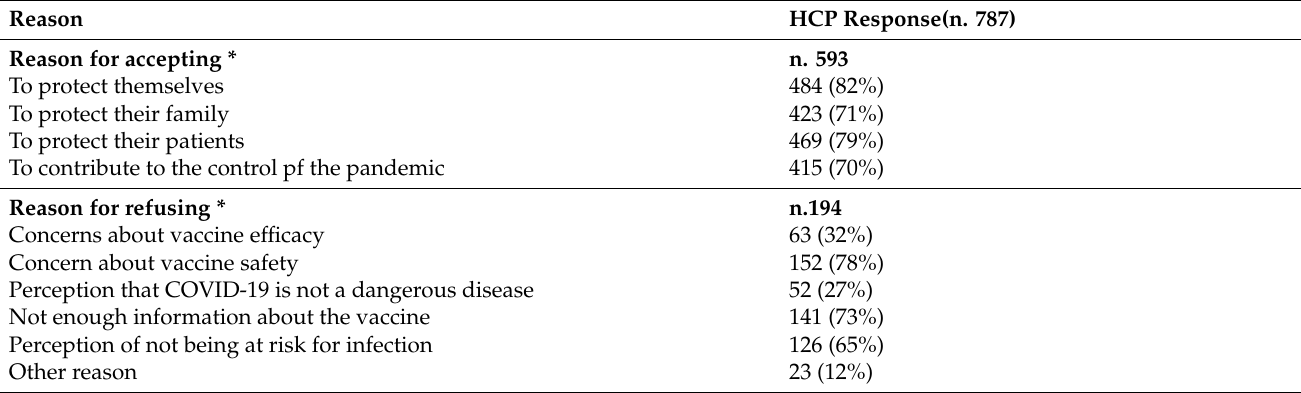
Table 6. Reason for accepting or refusing COVID-19 vaccination by HCP in